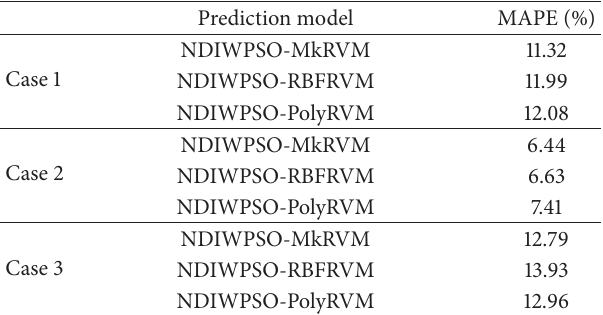
Table 1: The comparison of the mean absolute percentage errors among NDIWPSO-MkRVM, NDIWPSO-RBFRVM, and NDIWPSO-PolyRVM.